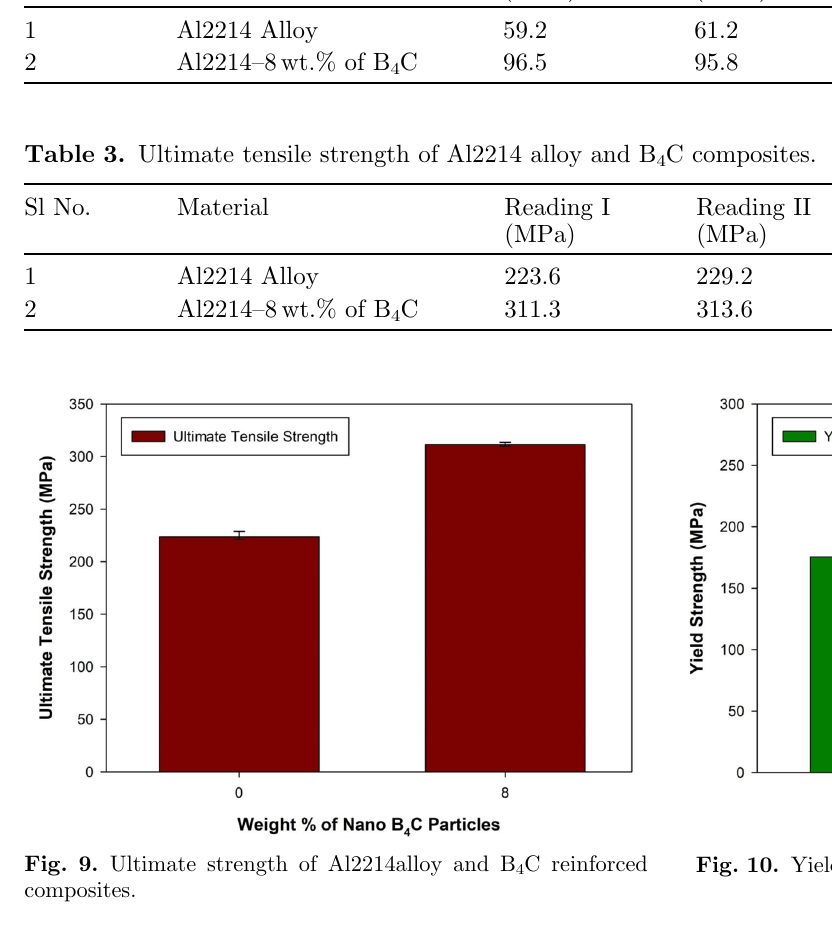
Table 2. Hardness of Al2214 alloy and B Sl No.